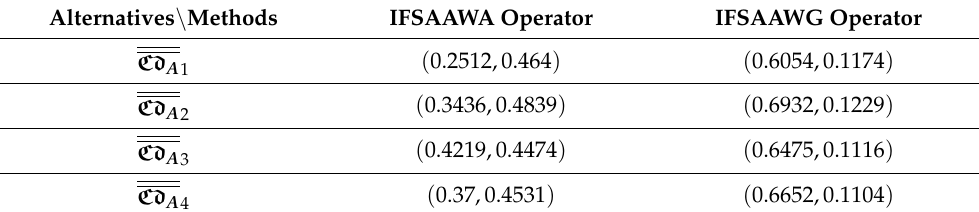
Table 5. Aggregated values for weighted averaging/geometric operators.